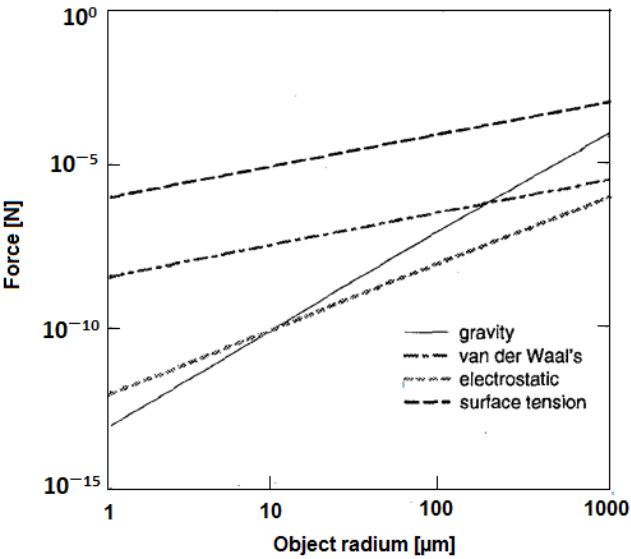
Figure 2. Orders of magnitude of gravitational, electrostatic, Van der Waals and tension forces vs. object size [13].